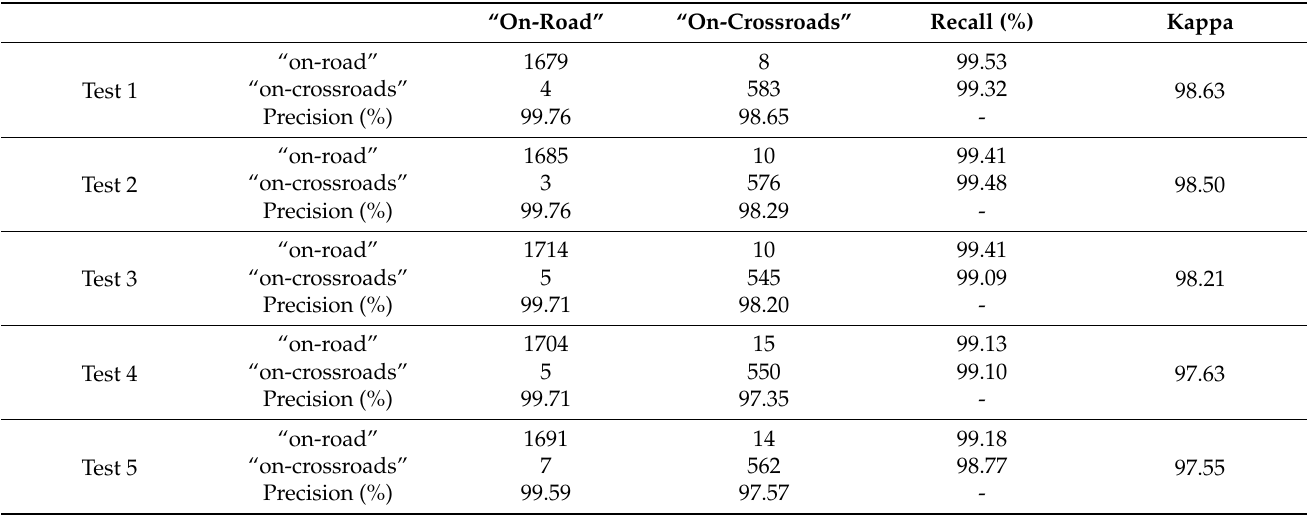
Table 3. Accuracy of the tracking points classification.